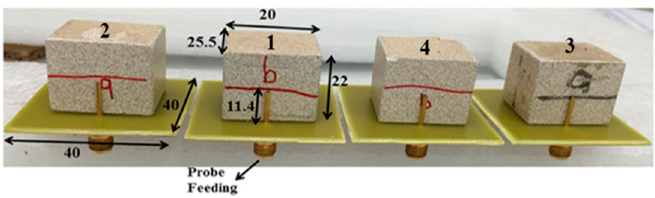
Figure 4. Prototype of the proposed DRA array.